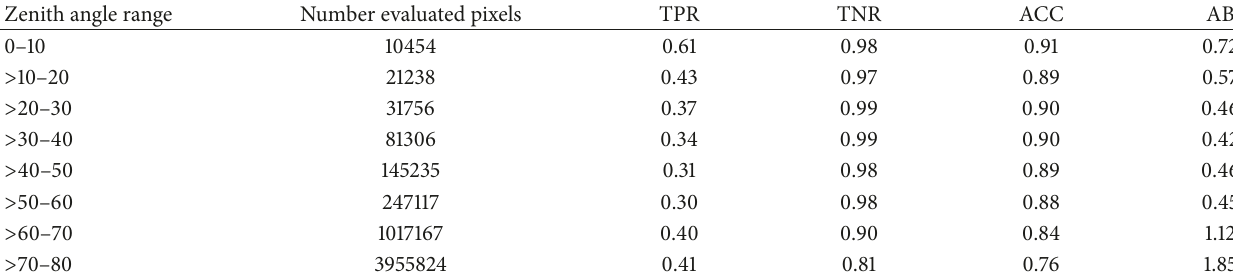
Table 3: Validation results for all 25 available Landsat scenes. For abbreviations refer to (5)–(7). Zenith angle